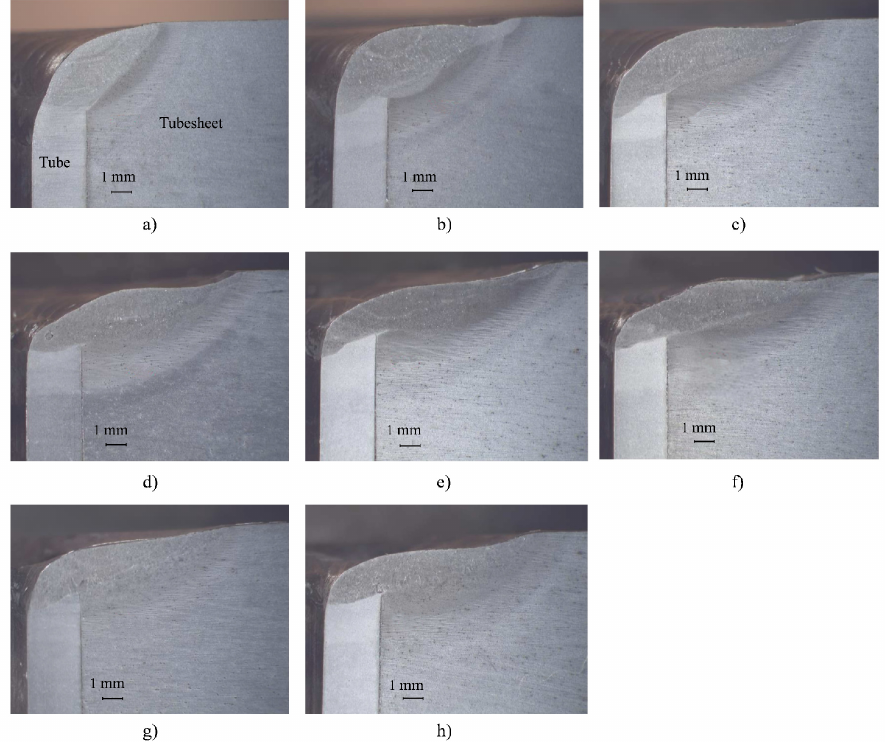
Figure 15. Macrographs of specimens at position 0 ◦ cut. Deviations in specimens of mockup 2: ( a ) +1 mm; ( b ) 0 mm (calibration value); ( c ) − 1 mm; ( d ) − 2 mm; ( e ) − 2.5 mm; ( f ) − 2.8 mm; ( g ) − 3 mm and ( h ) − 3 mm. In all macrographs, tube is on the ( left ) side and tubesheet on the ( right ) side.